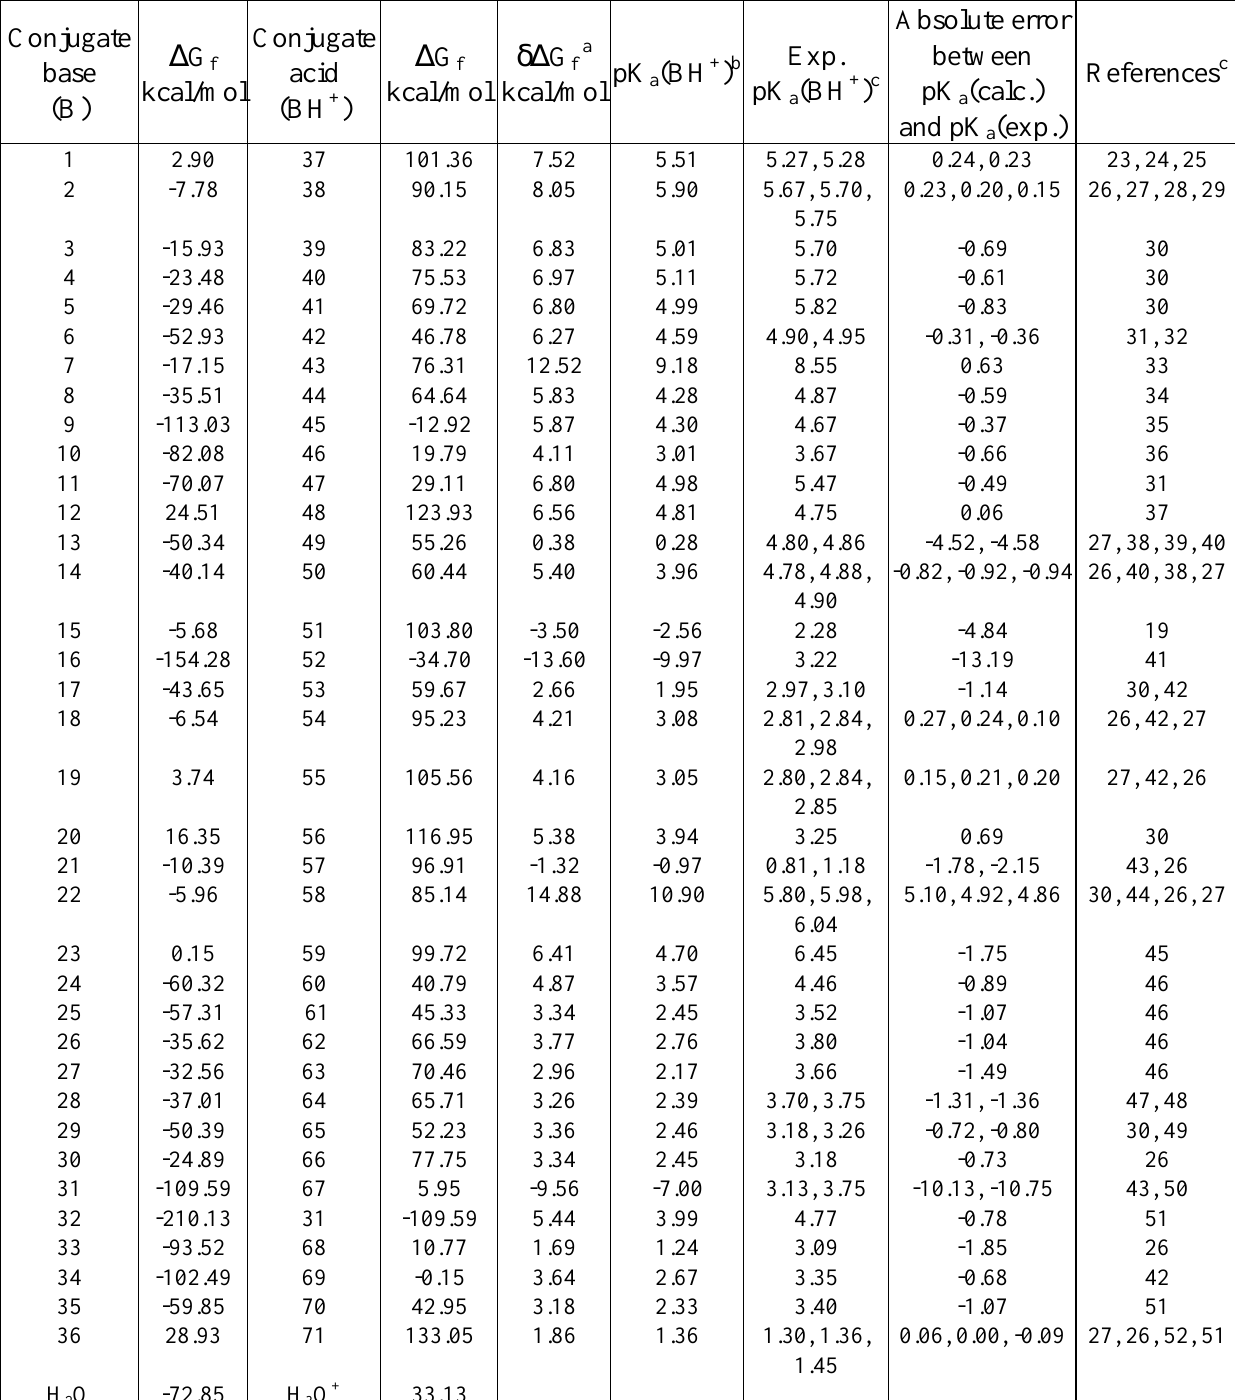
values for pyridines in aqueous solution ( e (cid:1) =78.4). a